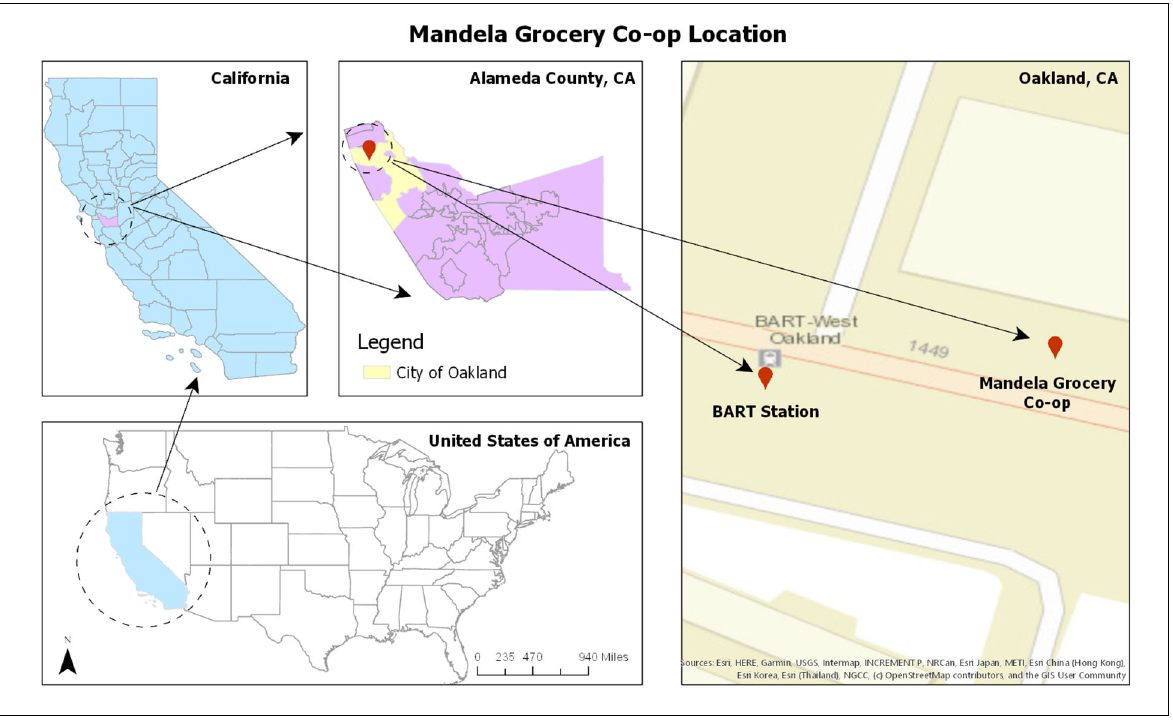
Figure 4. Mandela Grocery Co-op Location Map